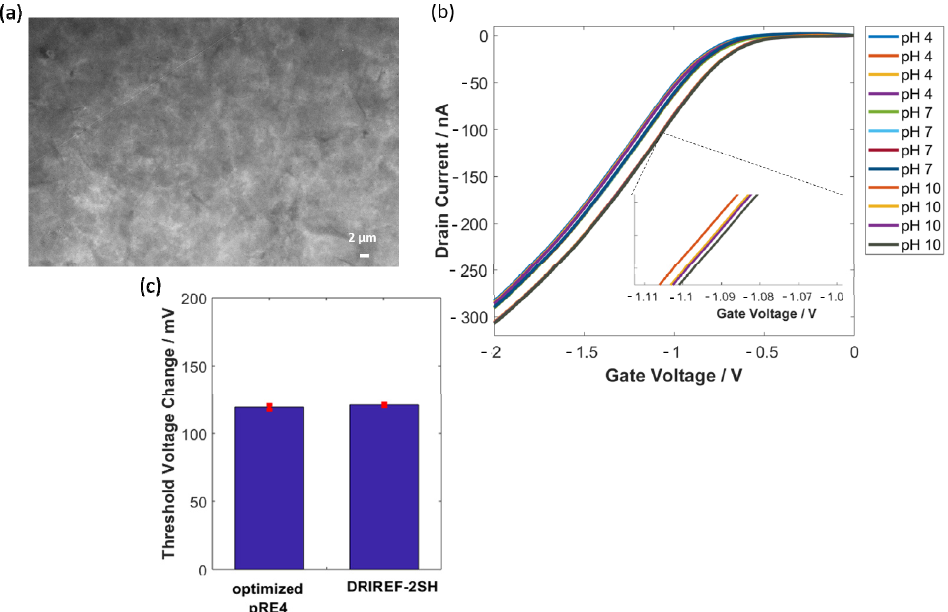
Figure 6. SEM image of the optimized GO coating ( a ). Multiple transfer characteristic measurements at different pH ( b ). Comparison in threshold voltage change due to changing the pH from 7 to 10 for an optimized pRE4 and a commercial Ag/AgCl RE ( c ).